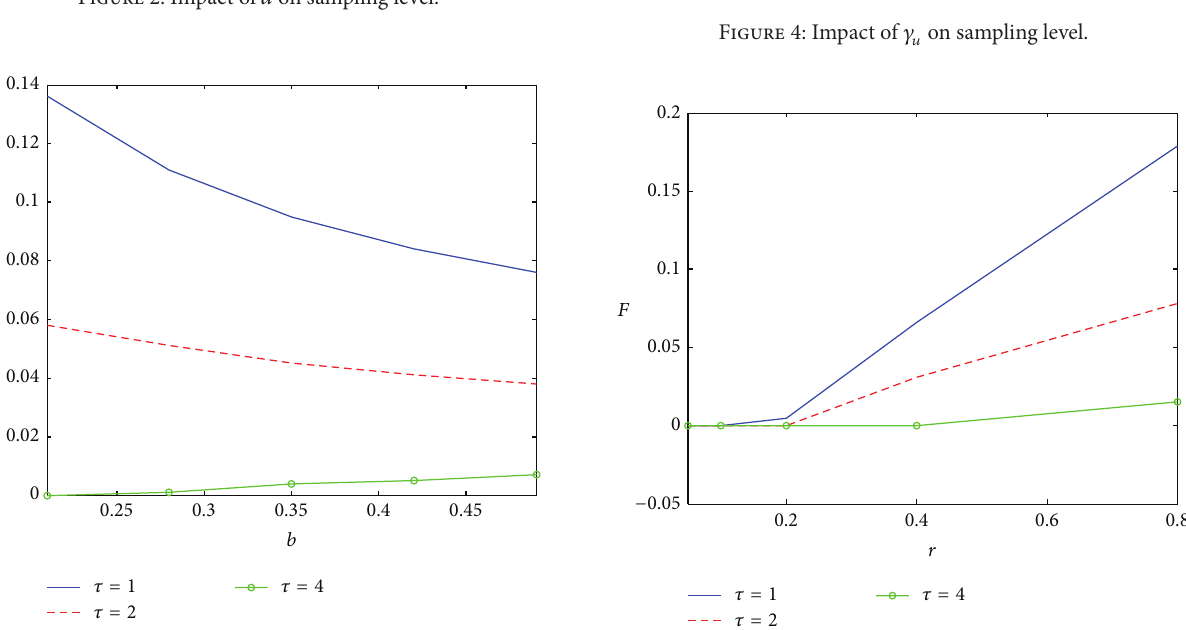
Figure 2: Impact of 𝑎 on sampling level.